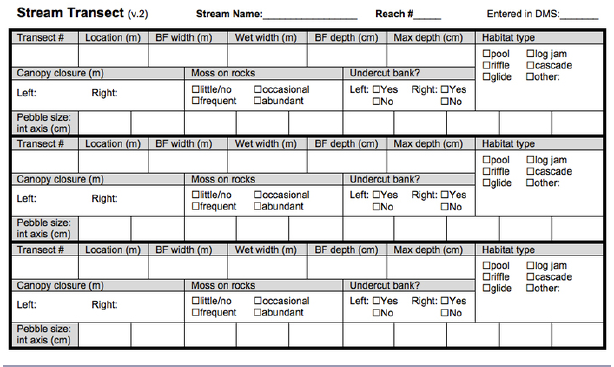
Fig. 2 . Stream transect card used to record stream characteristics at multiple cross-sectional transects for the Regional Monitoring System (RMS) of the Coastal Stewardship Network. The RMS also includes a stream visit, stream assessment, and salmon escapement card, shown in Appendix 1. Transect cards were developed by the Coastal First Nations – Great Bear Initiative and reproduced with their